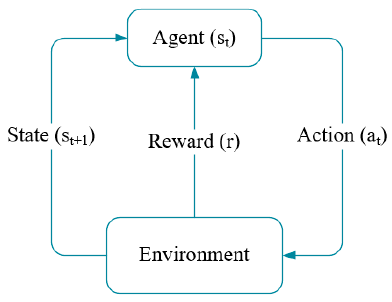
Figure 4. The progress of an agent interacts with the environment.